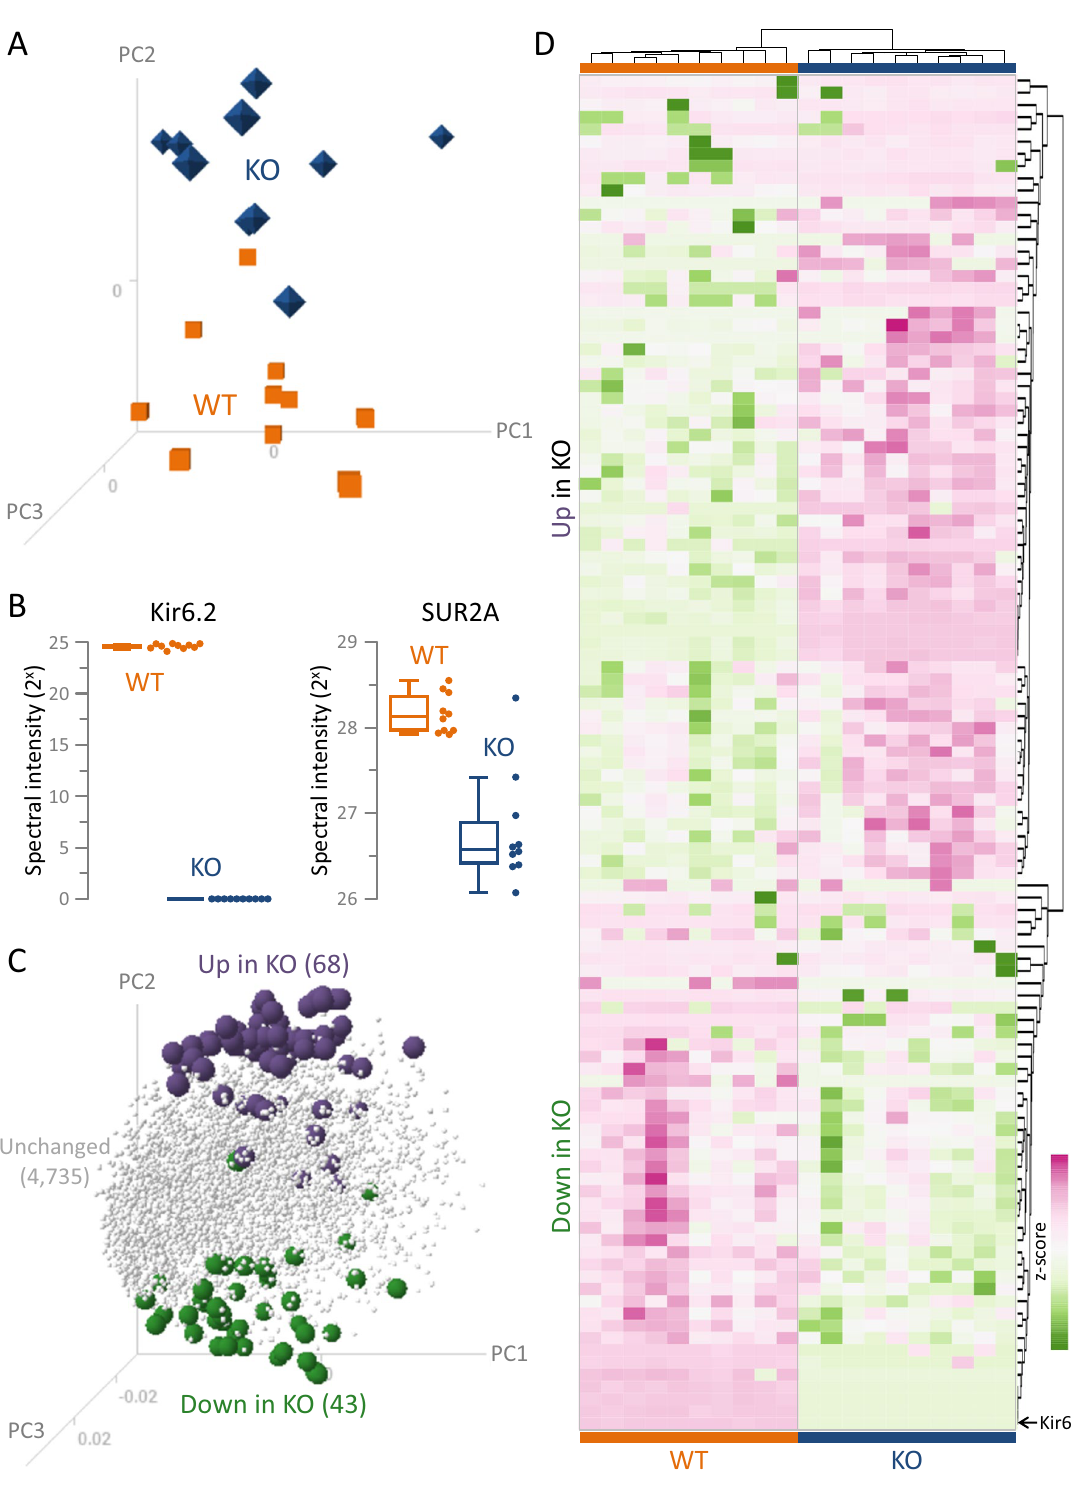
Figure 2. K ATP channel deficient proteome distinguished Kir6.2 knockout hearts. Differential proteomic profiling of wildtype (WT, n = 10) and Kir6.2 knockout (KO, n = 10) ventricular tissue extracts was carried out by data dependent analysis following nano-flow liquid chromatography tandem mass spectrometry. ( A ) KO segregated from WT in singular value decomposition 3-D principal component analysis (PCA), with PC1 representing 22%, PC2 9%, and PC3 7% of the variance yielded from the protein data input. ( B ) Kir6.2 expression was consistent in WT (orange boxplot, orange points) but undetected in KO (blue boxplot, blue points). The K ATP channel partner subunit SUR2A was also reduced (down 1.94-fold, FDR P = 0.016) in KO (blue) compared to WT (orange). ( C ) In PCA loading plot of the differentially expressed proteins (with FDR corrected P < 0.05), 68 were upregulated (purple spheres, 61.3% of the altered proteome) and 43 downregulated (green spheres, 38.7% of changes) in KO, displaying polar apposition interspersed by unaltered proteins (gray tetrahedrons). ( D ) Clustering by correlation distance and average linkage, a z-score transformed agglomerative heatmap (rose = increased, green = decreased) of differentially expressed proteins distinguished WT from KO (top dendrogram: WT orange, KO blue). The position of Kir6.2 is denoted by an